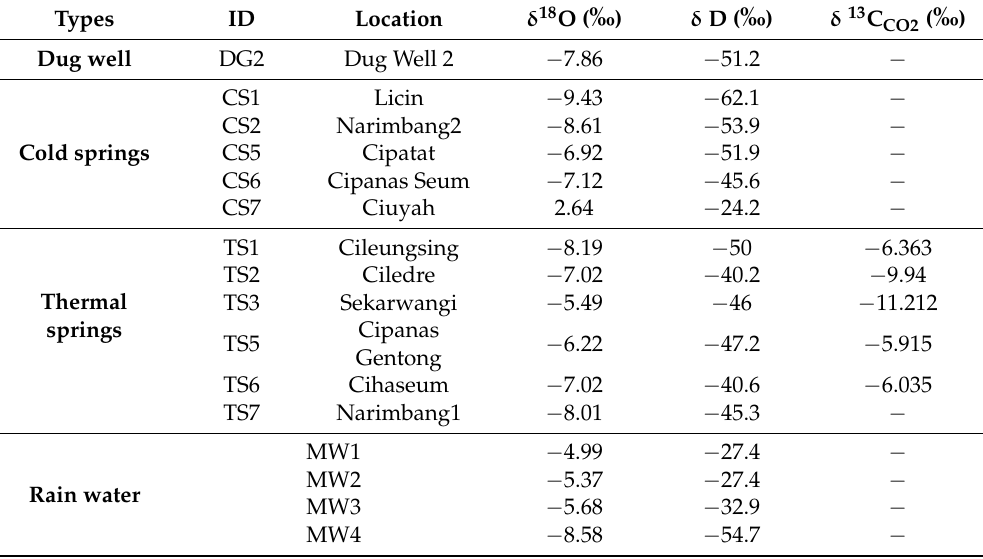
Figure 8. Relative Cl, Li and B contents (in mg/L) of Tampomas thermal springs and one chloride-type cold spring. All the thermal springs discharged at the Tampomas Volcano are distributed at the same cluster. CS7 springs show the same characteristics as thermal springs. Table 3. Natural stable isotope composition of some water samples in the Tampomas area.